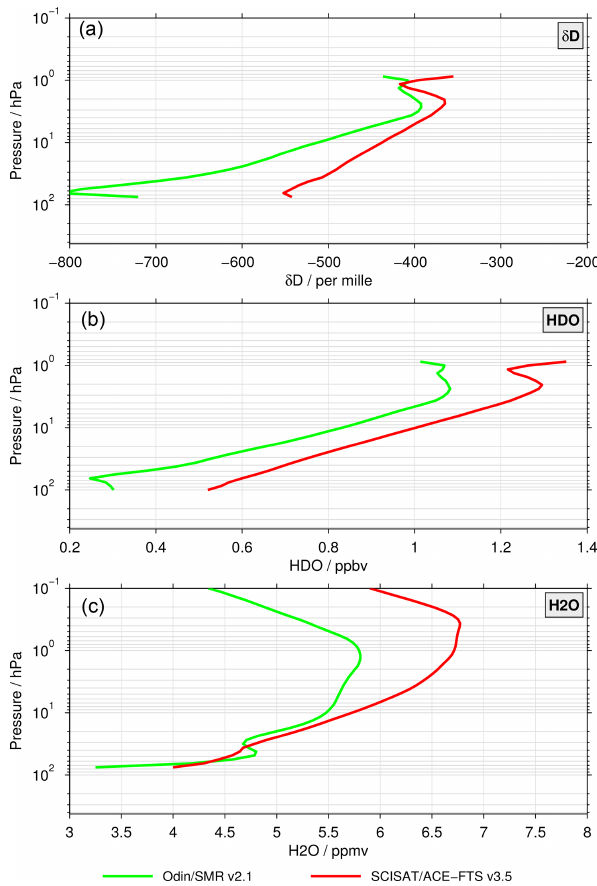
Figure 1. Profile-to-profile comparisons between the SMR v2.1 and ACE-FTS v3.5 data sets considering absolute profiles of δ D (a) , HDO (b) , and H 2 O (c)